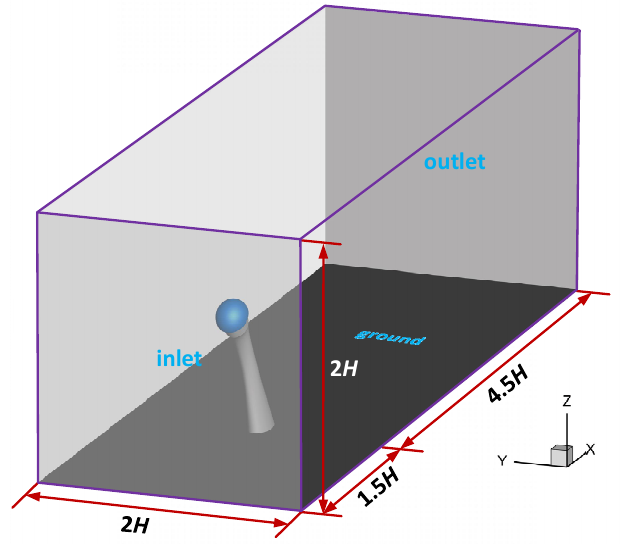
Figure 2. The computational domain in CFD simulations.